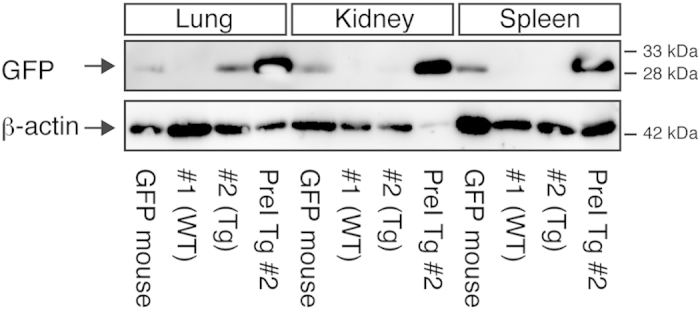
Comparison of expression levels of GFP protein from tissues in Tg monkeys and the GFP mice.Western blot was performed with 2.5 μg of proteins extracted from tissues of Tg monkeys, and the GFP mouse that carries one copy of the CAG promoter-GFP expression unit. Anti-GFP and β-actin antibodies were used to detect GFP and β-actin, respectively. Full-length blots are presented in Supplementary Fig. 3.